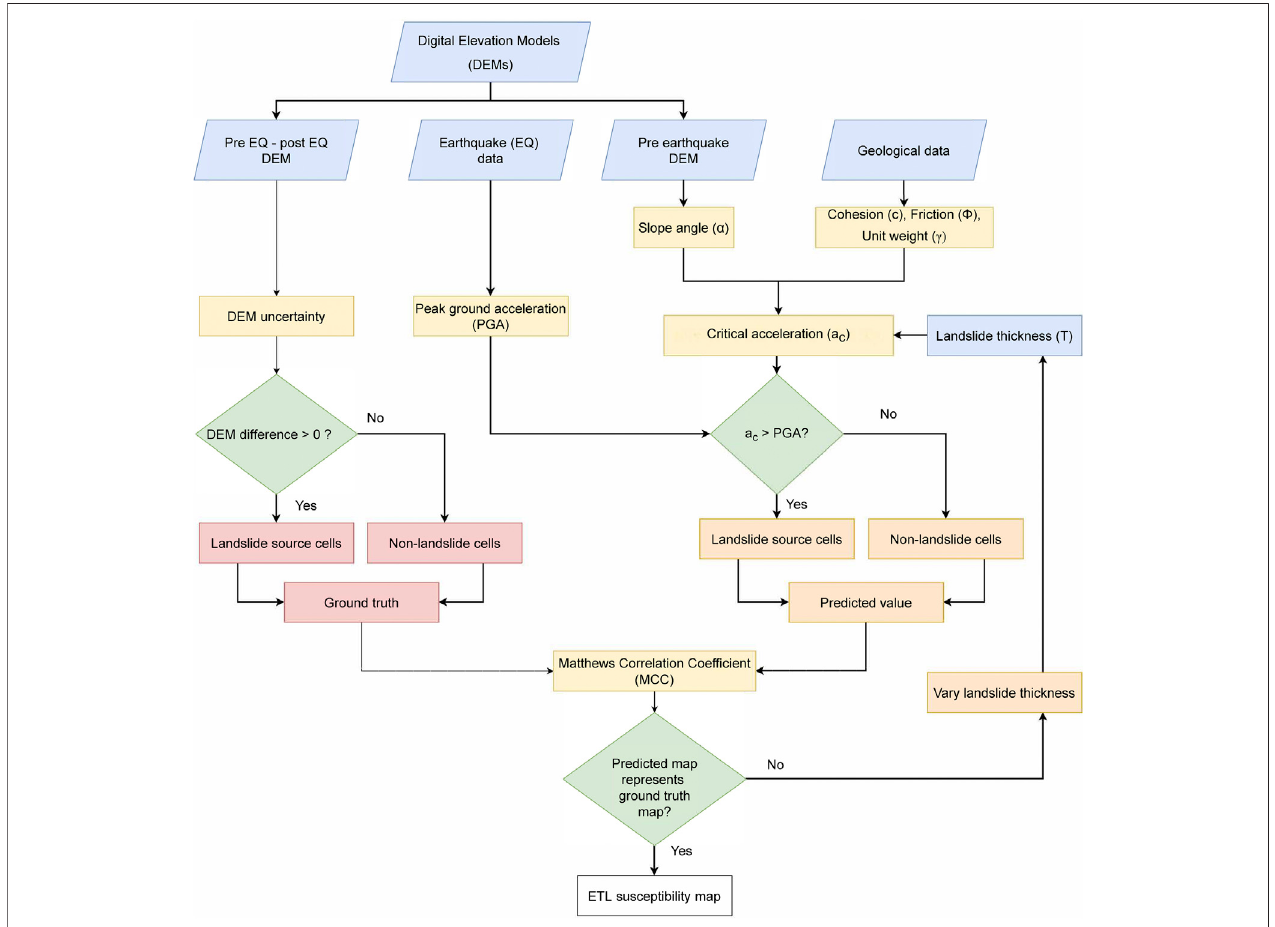
FIGURE 4 | Flowchart for creating ETL maps using DEM, critical acceleration, and earthquake